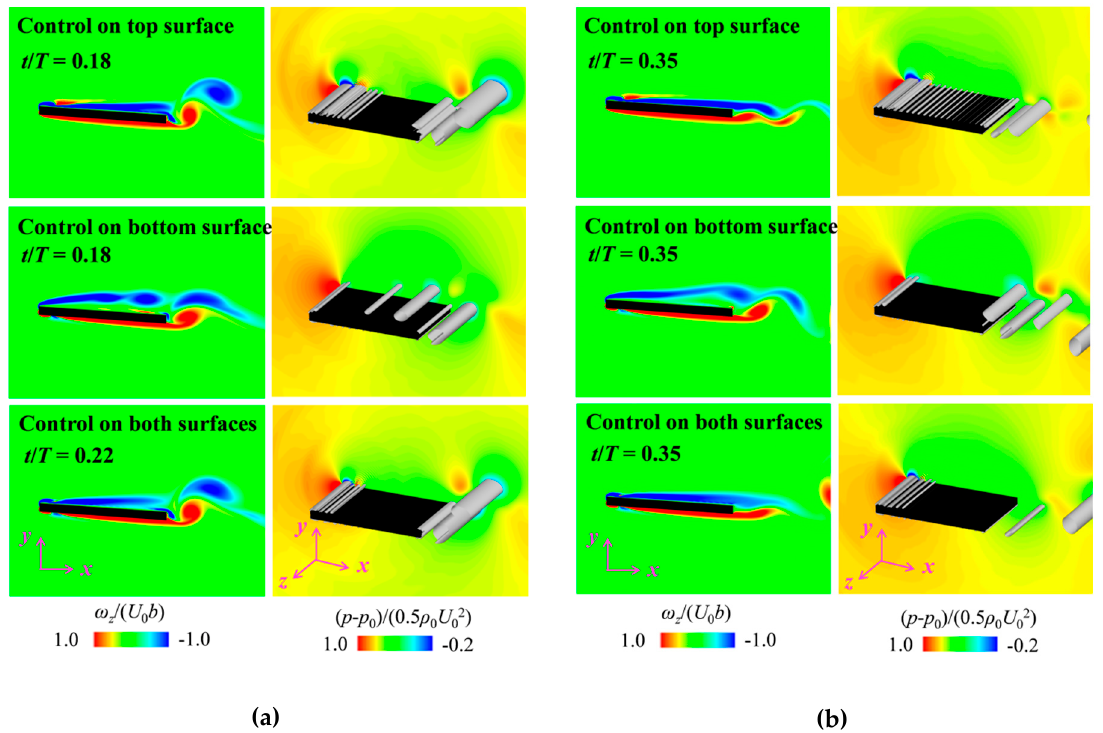
Figure 15. Flow fields for the baseline case and the case for the control by the actuator installed on the top surface. The left figures show the iso-surfaces of second invariant ( q /( U 0 / b ) 2 = 0.1) of velocity gradient tensor with the contours of pressure coefficient ( p - p 0 )/(0.5 ρ 0 U 02 ). The right figures show the contour of vorticity. ( a ) Time corresponding to local minimum force coefficient; ( b ) The time of t / T = 0.35.